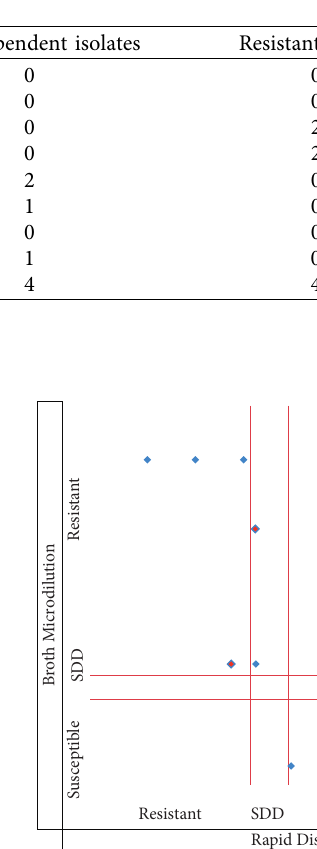
Figure 1: Distribution of susceptible profiles of Candida spp. according to the standard and rapid disk diffusion methods. SDD: fluconazole susceptible-dose dependent.